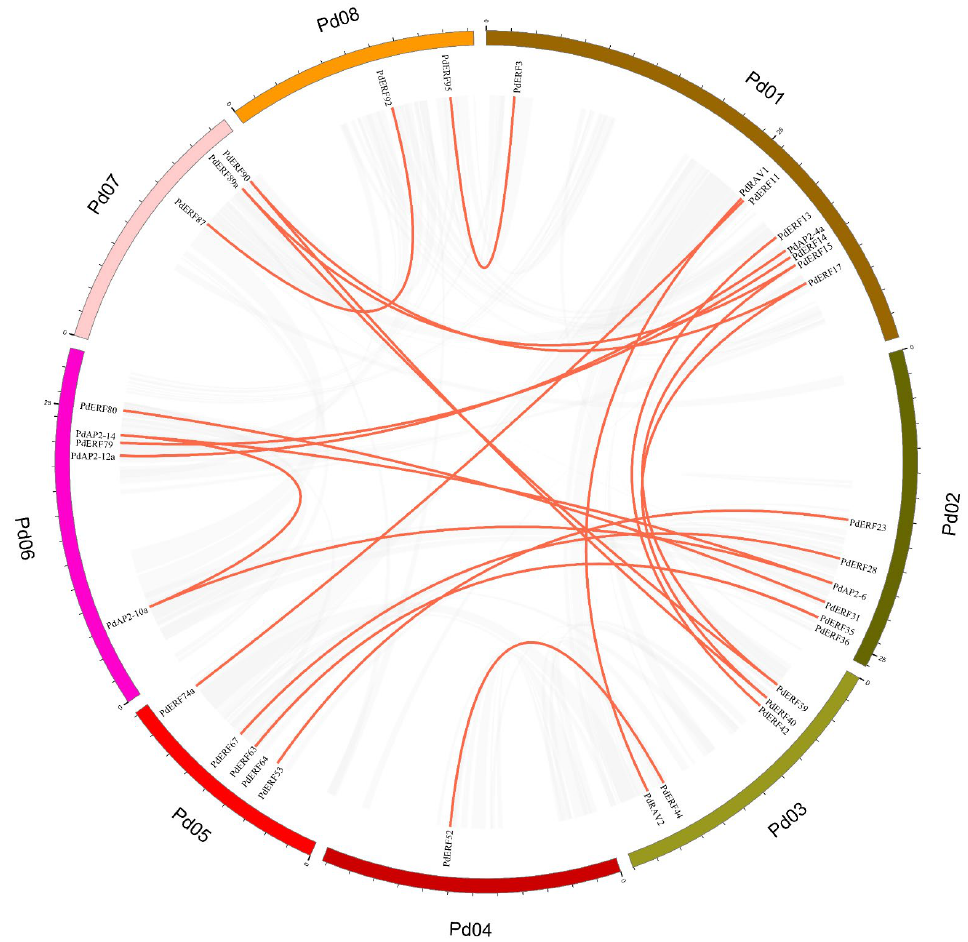
Figure 4. Interchromosomal relationships of the PdAP2/ERF genes in the almond genome. The red lines link the segmentally duplicated PdAP2/ERF gene pairs. To explore the evolutionary history of the members of the PdAP2/ERF family in al- mond, we constructed a collinear map of the AP2/ERF gene members in almond and those in four species: Arabidopsis thaliana , Oryza sativa , Malus domestica, and Prunus persica (Fig- ure 5). The results showed that there were 56, 26, 164, and 109 pairs of collinear AP2/ERF genes between almond and Arabidopsis thaliana , Oryza sativa , Malus domestica and Prunus persica , respectively (Table S9). It is worth noting that some PdAP2/ERFs have a collinear relationship with two or more AP2/ERF members in Arabidopsis thaliana , Oryza sativa, and Malus domestica , suggesting that these genes play important roles in the evolution of the PdAP2/ERF gene family. There is a one-to-one collinearity in genes from almond and peach. It is speculated that the AP2/ERF genes of these two plants have a low degree of separation during evolution and are highly conserved.